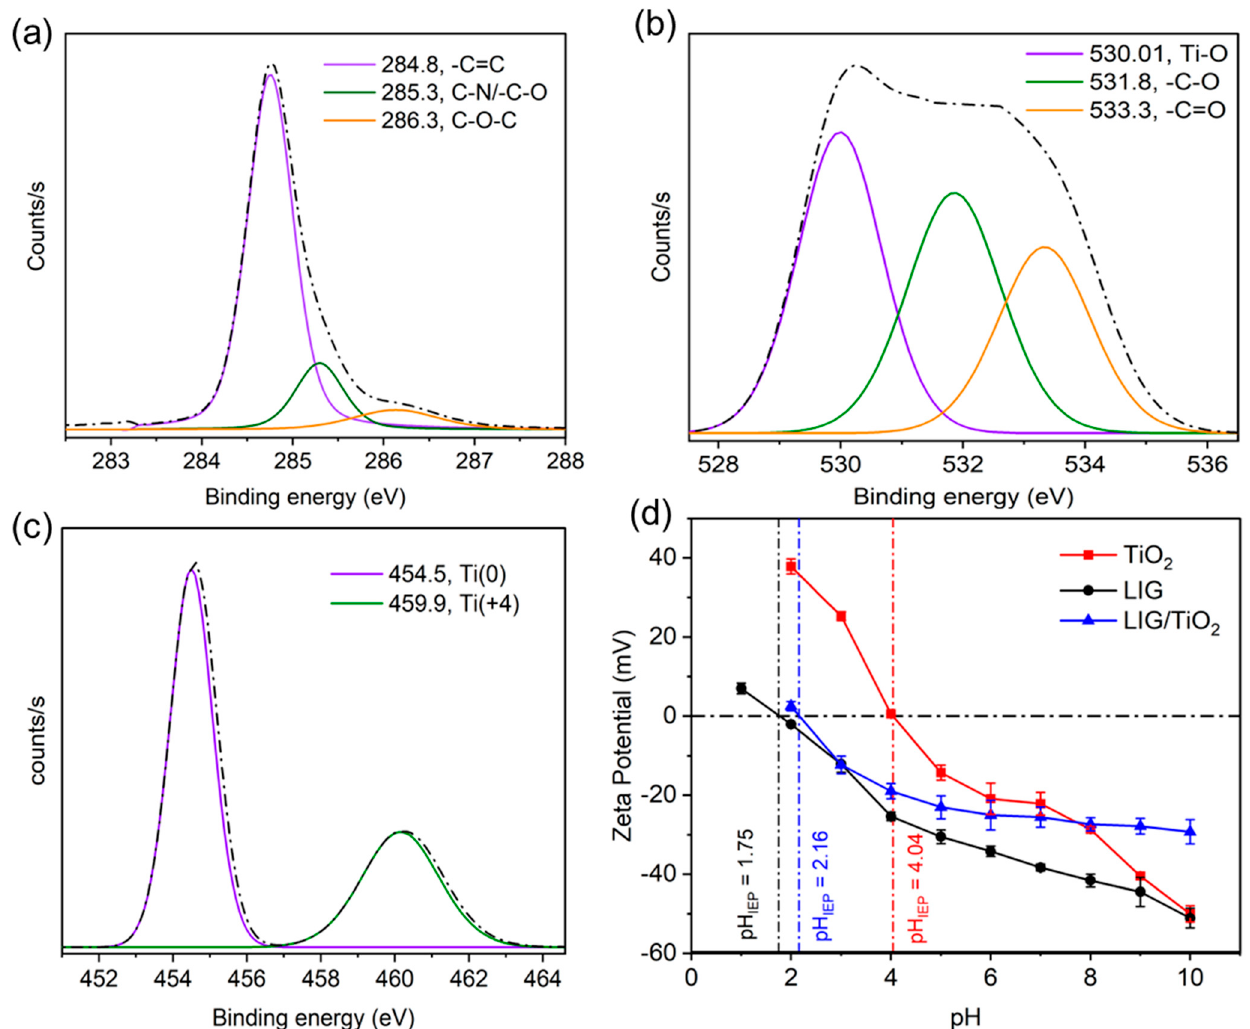
Figure 3. Deconvolution of ( a ) C1s, ( b ) O1s, ( c ) Ti2p; ( d ) zeta potential measurement of LIG, TiO 2 , and LIG/TiO 2 .